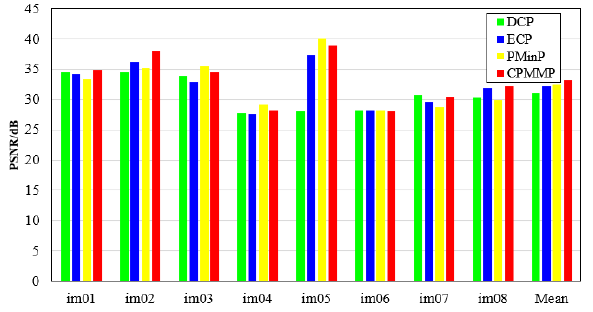
Figure 7. Quantitative evaluation of the simulated GF-2 multi- spectral image.